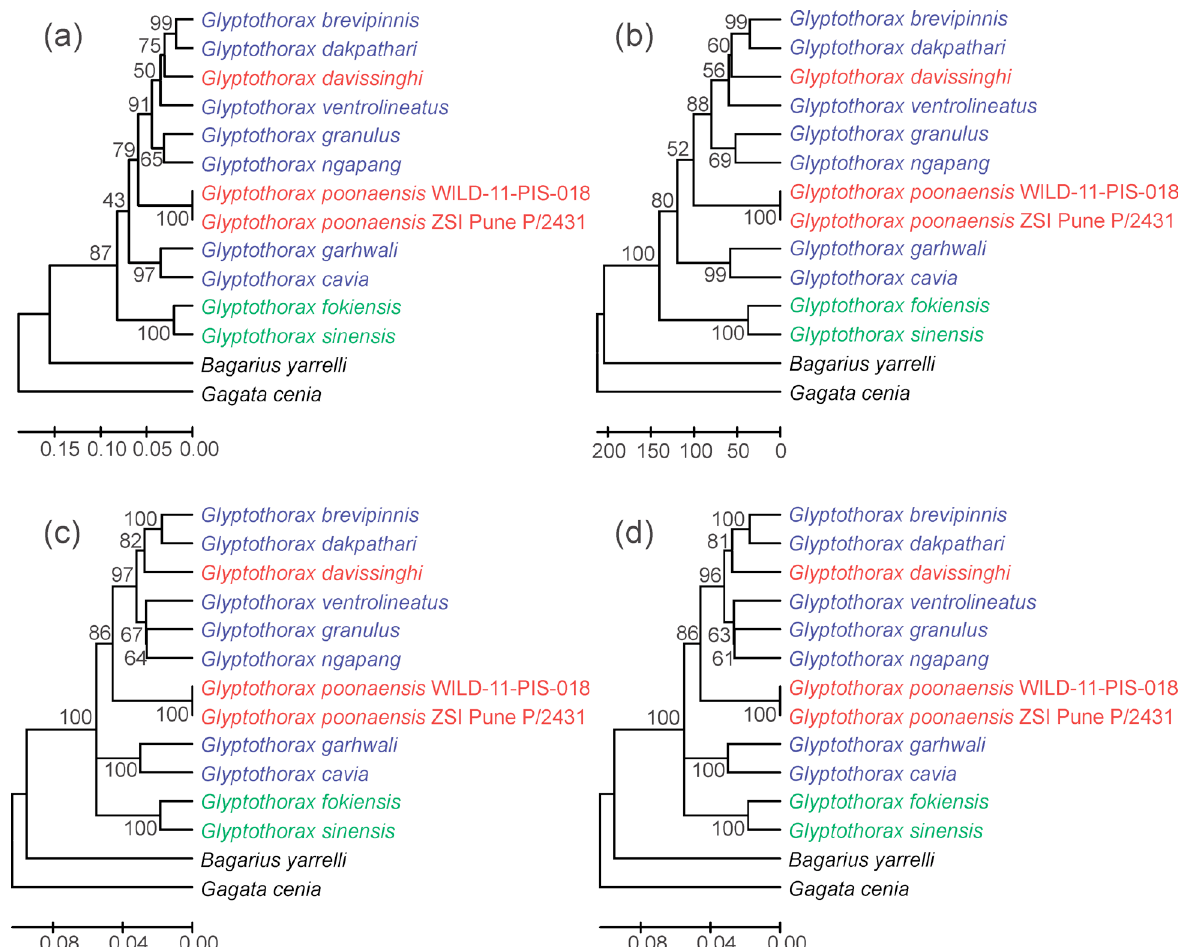
Figure 2. Phylogenetic position of Glyptothorax poonaensis . Phylogenetic tree constructed using (a) maximum likelihood, (b) maximum parsimony, (c) minimum evolution and (d) neighbor joining analysis using 2120 base pairs of partial 16S rDNA, cyt-b and cox1 gene sequences. Values at each node are Bootstrap values for 1000 iterations. Gagata cenia and Bagarius yarrelli are used as out groups. Species names in blue indicate northern Indian and northeastern Indian species, species names in green indicate Chinese species and species name in red are Western Ghats